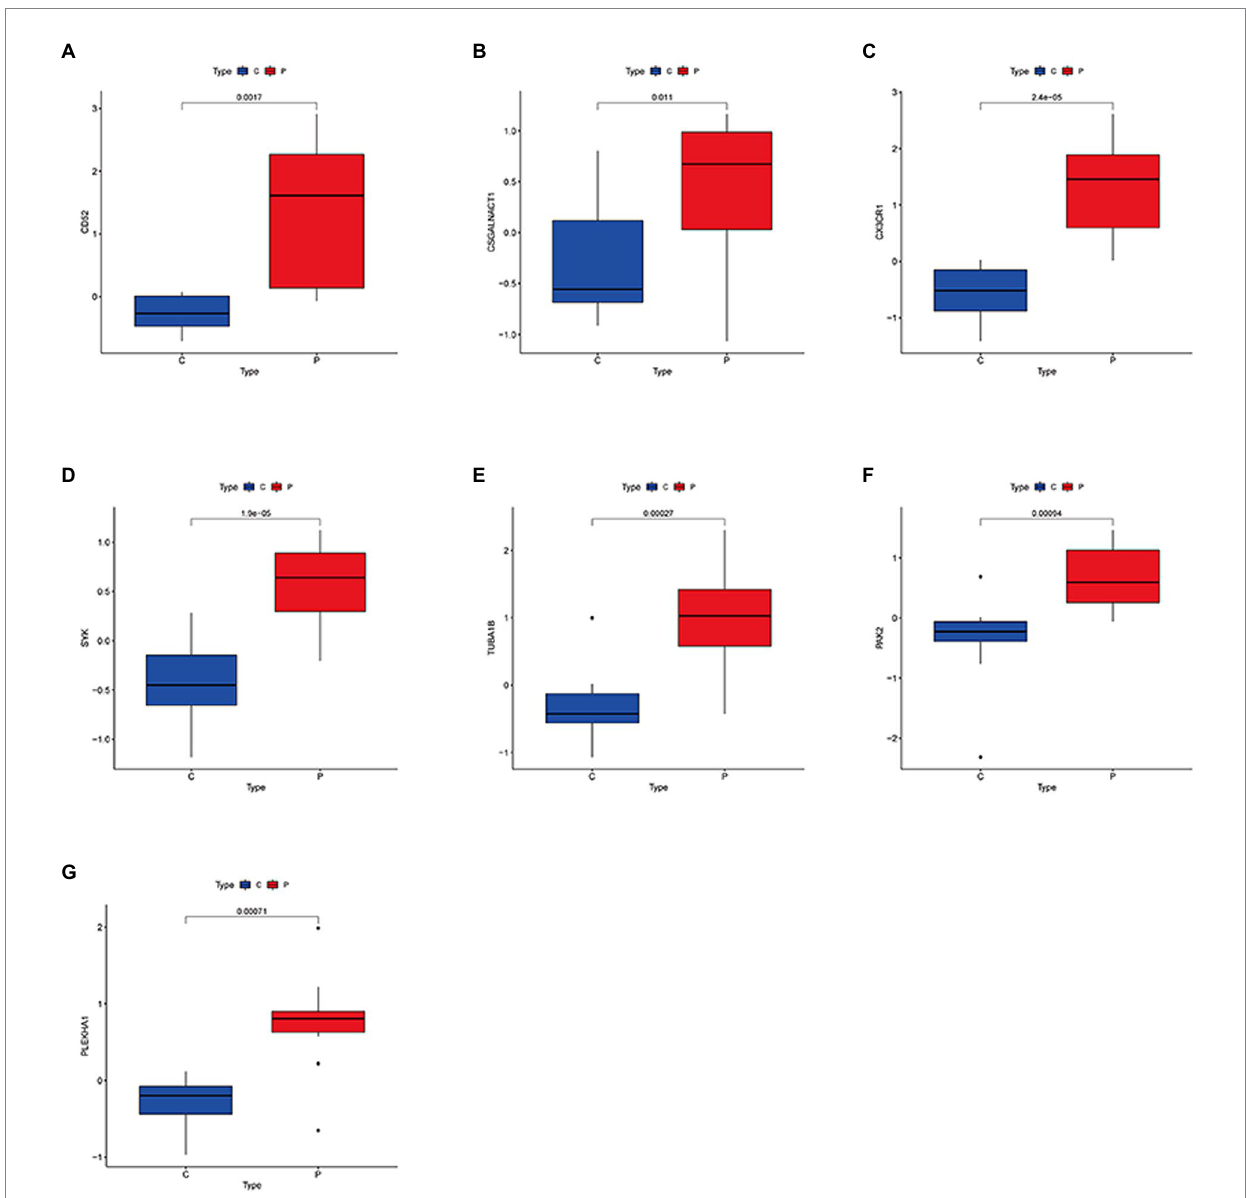
FIGURE 3 Expression levels of common biological markers in DN and MS. (A–G) CD52 ; CSGALNACT1 ; CX3CR1 ; SYK ; TUBA1B ; PAK2 ;